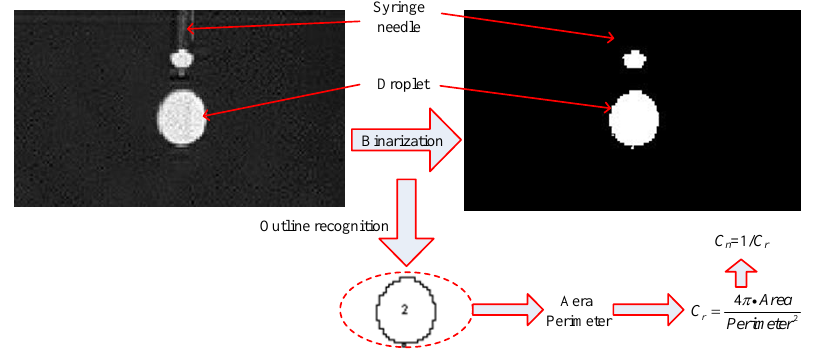
Figure 4. The process of binarization for raw picture.